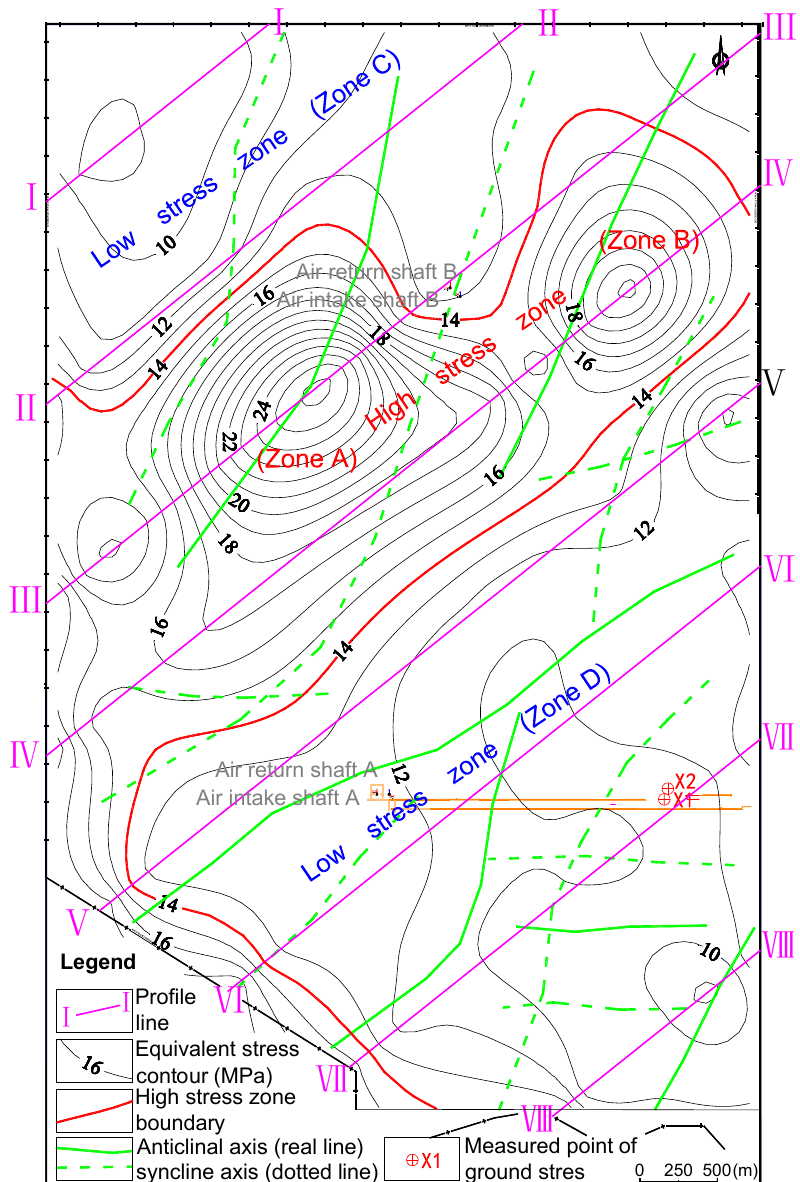
Figure 3. Equivalent stress distribution map of the No. 3 coal seam floor and the positions of the designed profile.